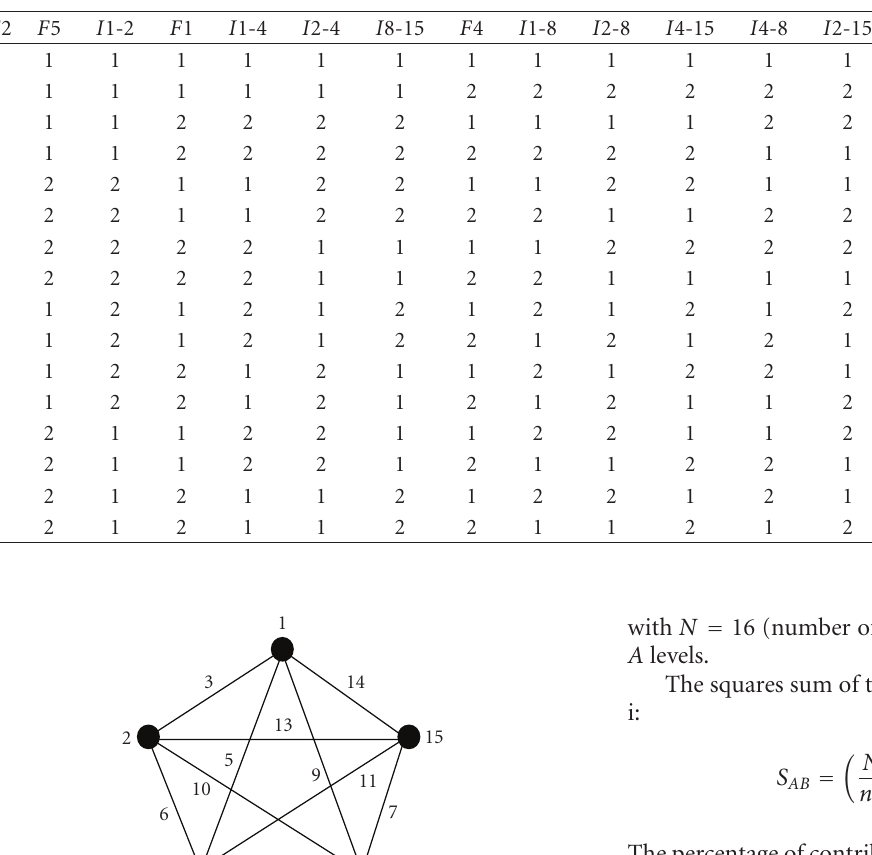
Table 2: Taguchi orthogonal array L 16 (2 15 ).